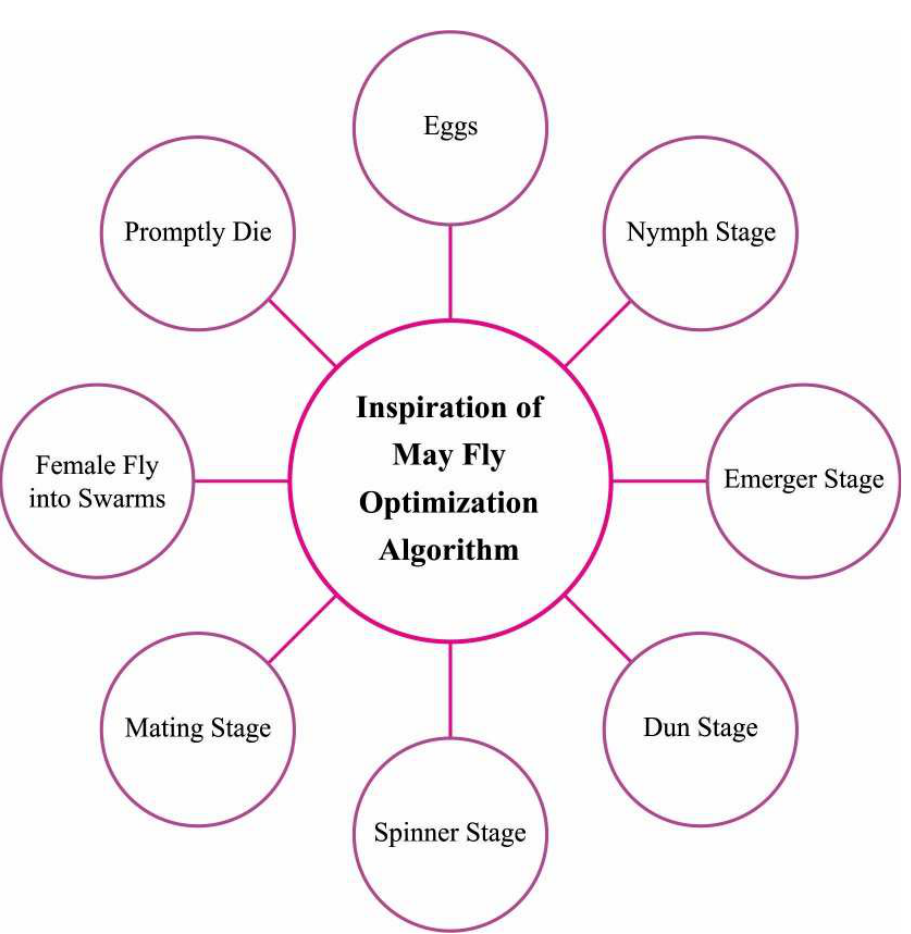
Figure 2. Steps involved in MFO.